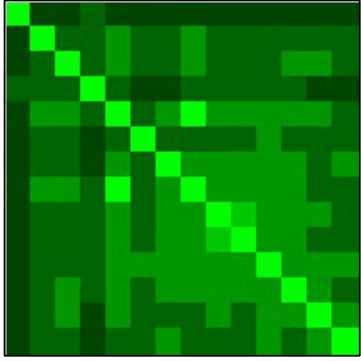
Figure 4. Image of the correlation matrix.